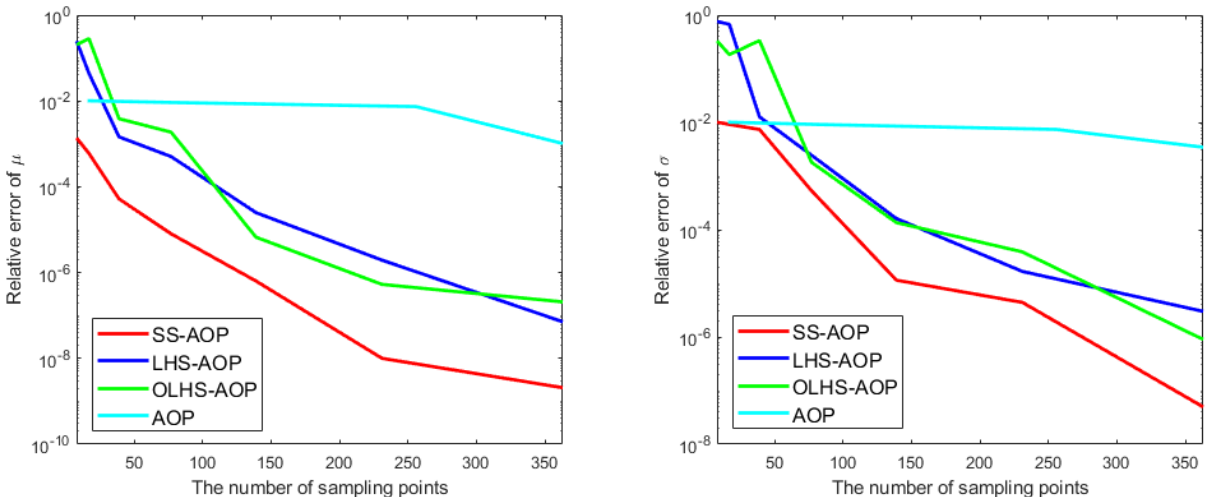
Figure 5. The relative error of mean value and variance for Case 3.